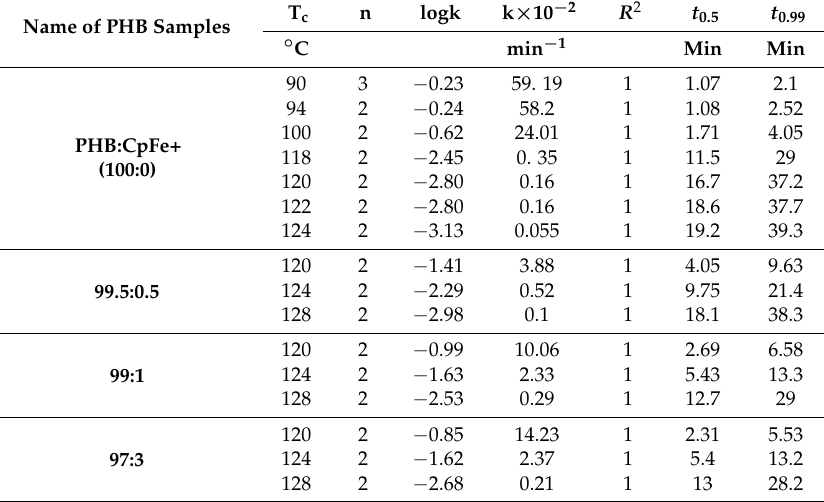
Table 2. Isothermal crystallization kinetics parameters of the pure PHB and PHB/ CpFe + nanocomposites based on the Avrami model.